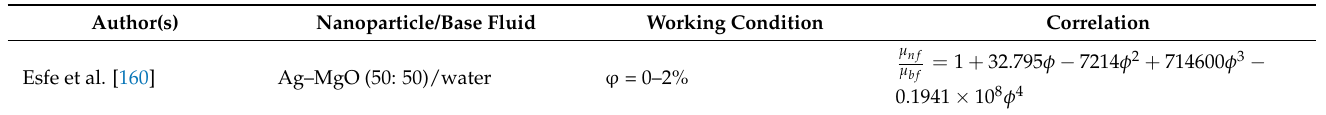
Table 3. Summary of correlation for the viscosity of hybrid